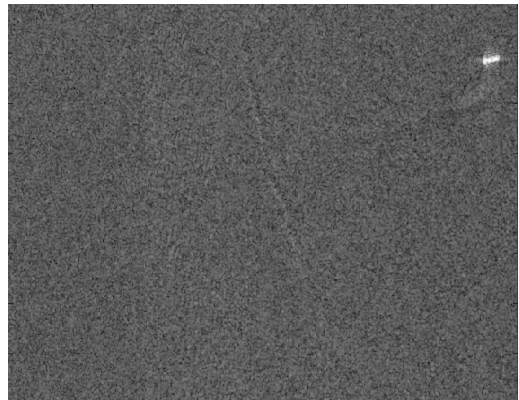
Figure 6. Example of Sentinel I SAR map including a vessel and its corresponding wake pattern (contains modified Copernicus Sentinel data, 2018). The signal has been processed by a MAP filtering procedure and represented on a logarithmic scale.